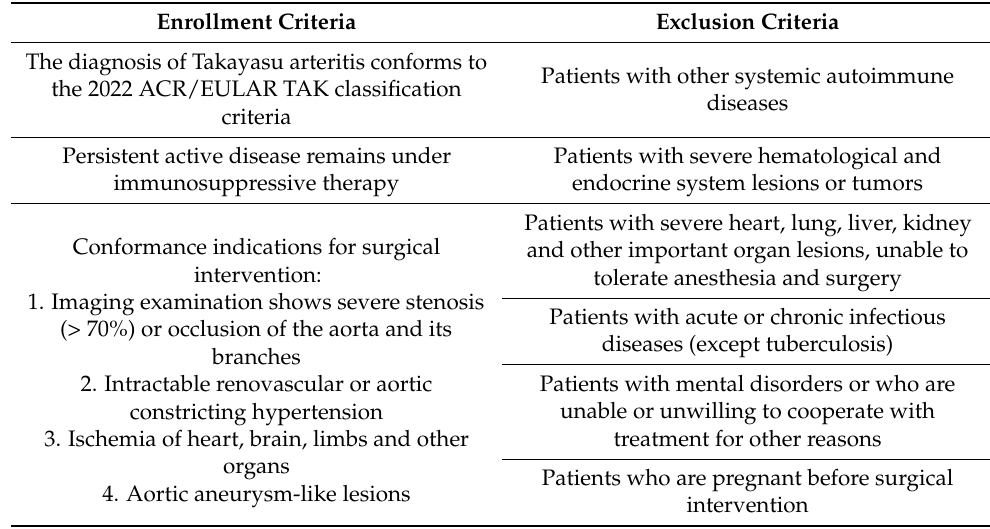
Table 1. Inclusion and exclusion criteria for patients with Takayasu arteritis. Enrollment Criteria Exclusion